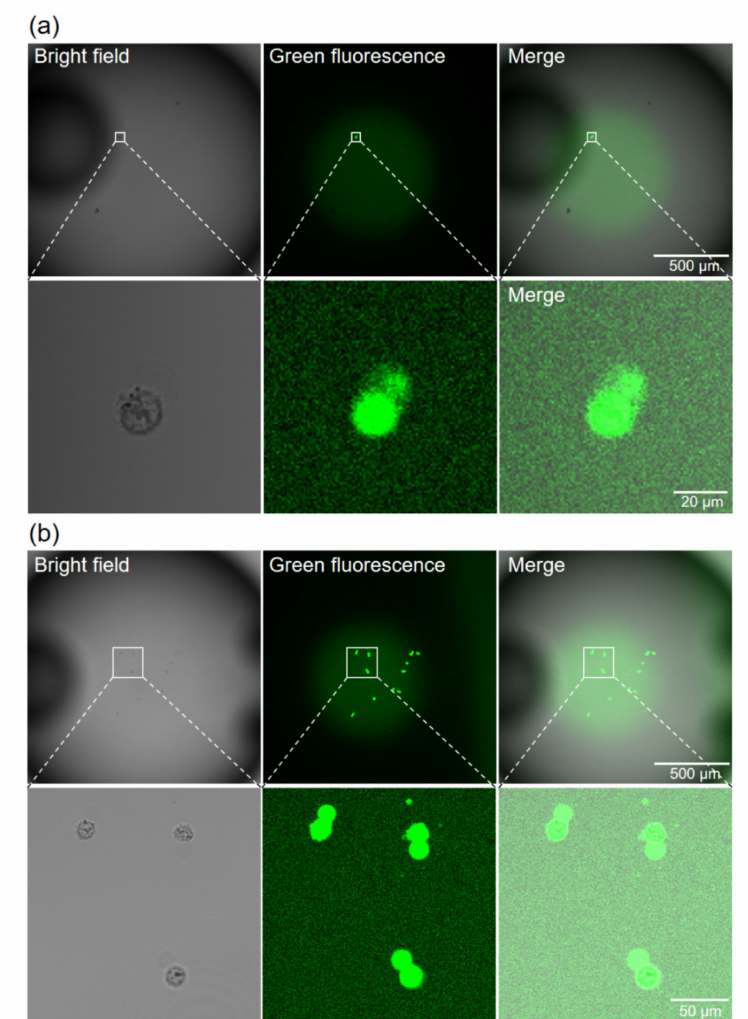
Figure 6. Observation of cells in the PCR mixture on the well bottom. ( a ) Well containing a single KO-expressing cell. ( b ) Well containing 12 non-expressing